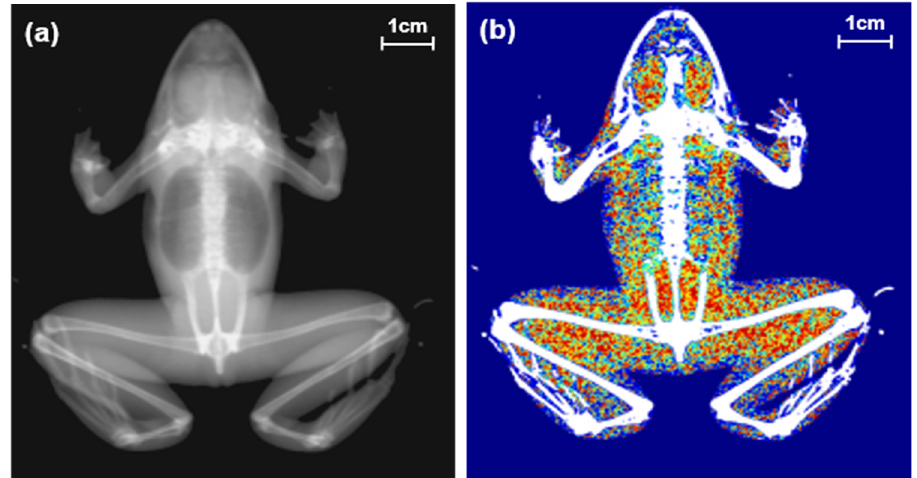
Figure 1. Two types of images of a black-spotted pond frog using dual energy X-ray absorptiometry: ( a ) body image; ( b ) composition image (green areas: lean body contents, red areas: fat contents).